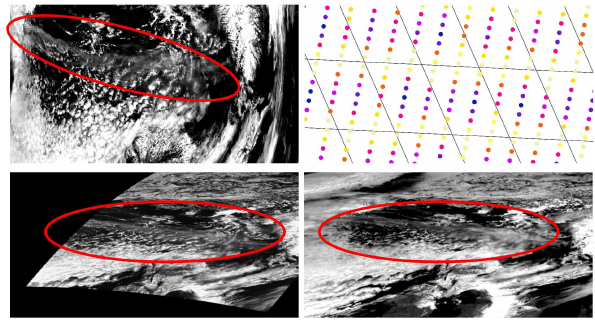
Fig. 2. Aggregation of MODIS data into SEVIRI’s grid system; the ash cloud is marked by the red oval. Top left: an example of original MODIS data (part of MODIS band 1 data showing the Eyjafjallj¨okull ash cloud over the North Sea on 15 April 2010 at 11:35UTC). Top right: A scheme of SEVIRI’s point spread function – each dot represents a MODIS measurement, thus it is coloured according to its position within the SEVIRI pixel (dark purple dots represent greater weight than pale yellow dots). Bot- tom left: MODIS data transformed in the SEVIRI grid system (see the difference in the overall geometry that is a consequence of a difference in viewing angles of both instruments). Bottom right: SEVIRI data retrieved at approximately the same time as MODIS